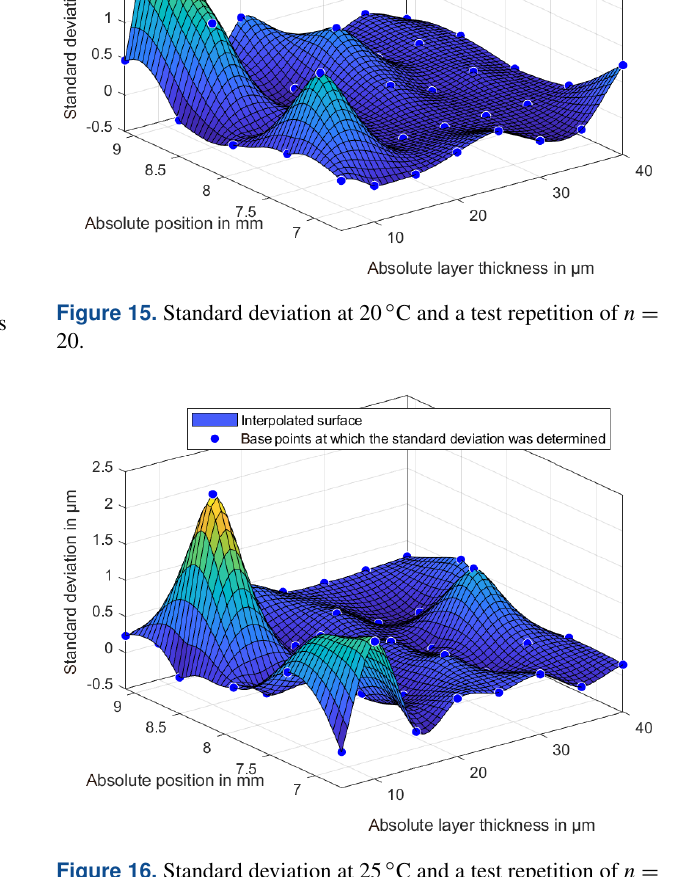
Figure 14. Deviation of the measured BF152DL layer thicknesses at a temperature of 30 ◦ C to the reference measurement at 20 ◦ C.